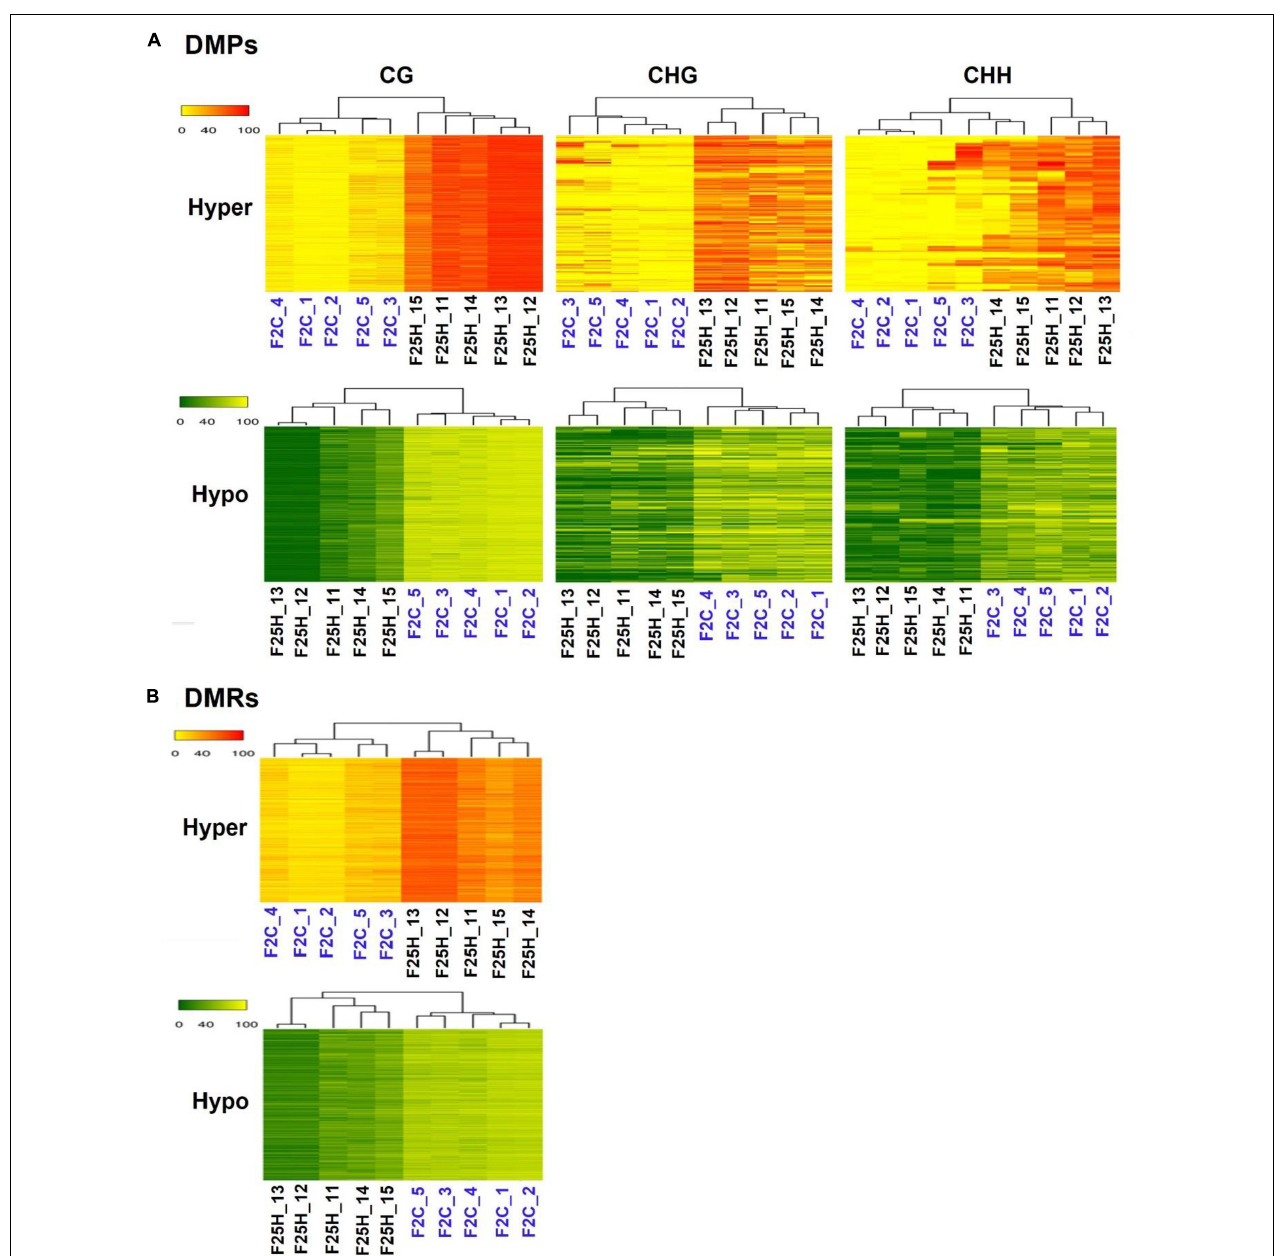
FIGURE 5 | A hierarchical clustering heatmap analysis. (A) Heat maps of DMPs for hypermethylated cytosines (the upper panel) and hypomethylated cytosines (the lower panel) in CG, CHG, and CHH contexts in F25H vs. F2C. Differentially methylated cytosines in the genome with differences of > 50% in F25H vs. F2C. (B) Heat maps of DMRs of hypermethylated cytosines (the upper panel) and hypomethylated cytosines (the lower panel) in CG contexts in F25H vs. F2C. Differentially methylated positions in the genome with differences > 50% in F25H vs. F2C. In ‘the upper panel’, the red section indicates the larger percentage of methylation, and the yellow section indicates the lower percentage, and in “the lower panel,” the green section indicates the larger percentage of methylation and the yellow one indicates the lower percentage, q -value < 0.01.